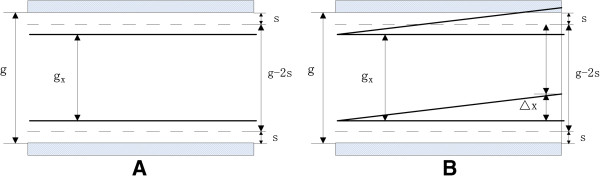
Ions passing through the drift tube at the situation ofgx<g-2swhen the compensation voltage (A) is UM(B) deviates from UM.